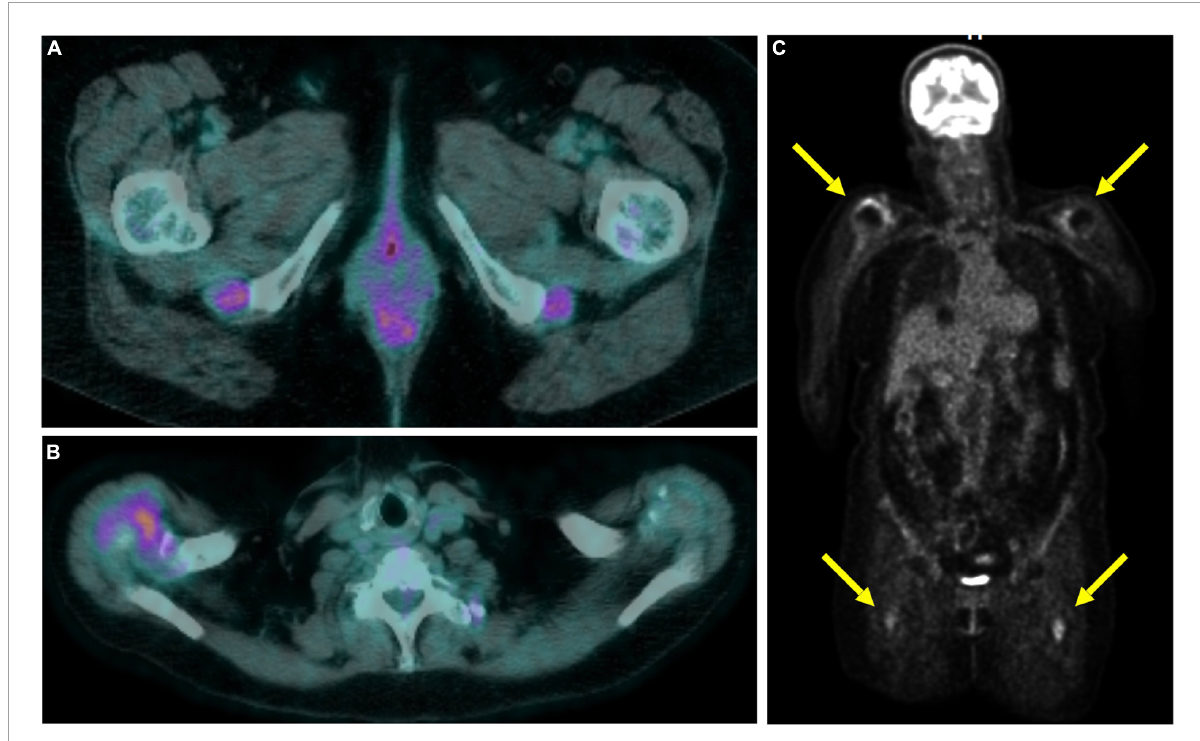
FIGURE2 Total body 18F-fluorodeoxyglucose positron emission tomography-computed tomography ( 18 F-FDG-PET/CT) in a polymyalgia rheumatica (PMR) patient with persistent articular inflammation in the ischial tuberosities (A) and right shoulder (B) . Coronal slice in maximum intensity projection showing the uptake at the shoulders and subtrochanteric bursae (C)